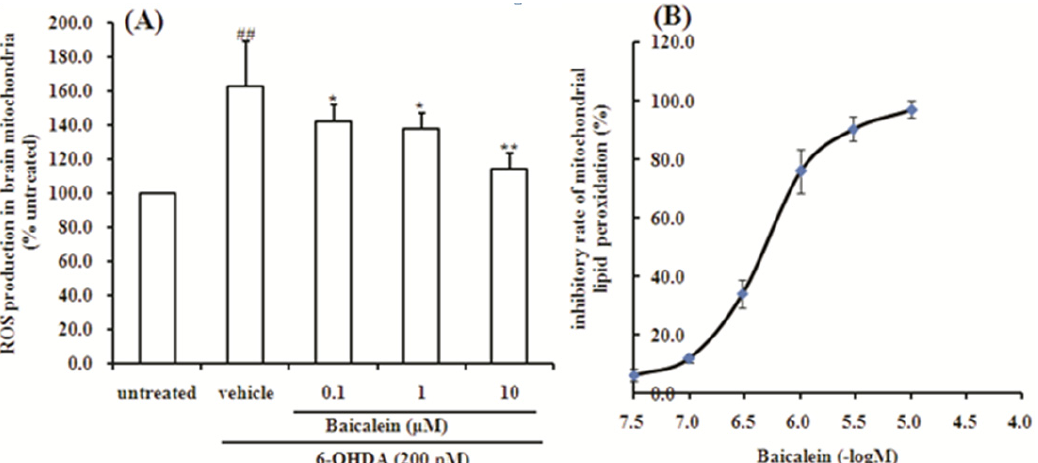
Figure 6. Effect of baicalein on generation of ROS induced by 6-OHDA and lipid peroxidation in rat brain mitochondria. ( A ) ROS production in rat brain mitochondria; ( B ) lipid peroxidation in rat brain